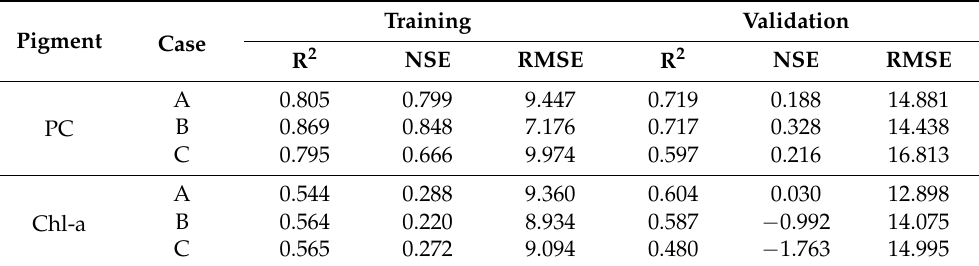
Figure 3. Comparison of concentration of two pigments (PC, Phycocyanin; Chl-a, Chlorophyll-a) between observed and estimated values from each of the following optimized regression methods: ( a ) partial least square, ( b ) random forest, ( c ) gradient boosting regression tree, ( d ) support vector machine, ( e ) K-nearest neighbors, and ( f ) artificial neural network. Training is denoted by a black closed circle. Validation is denoted by a red open circle. Table 5. Comparison of change in artificial neural network (ANN) performance according to input band